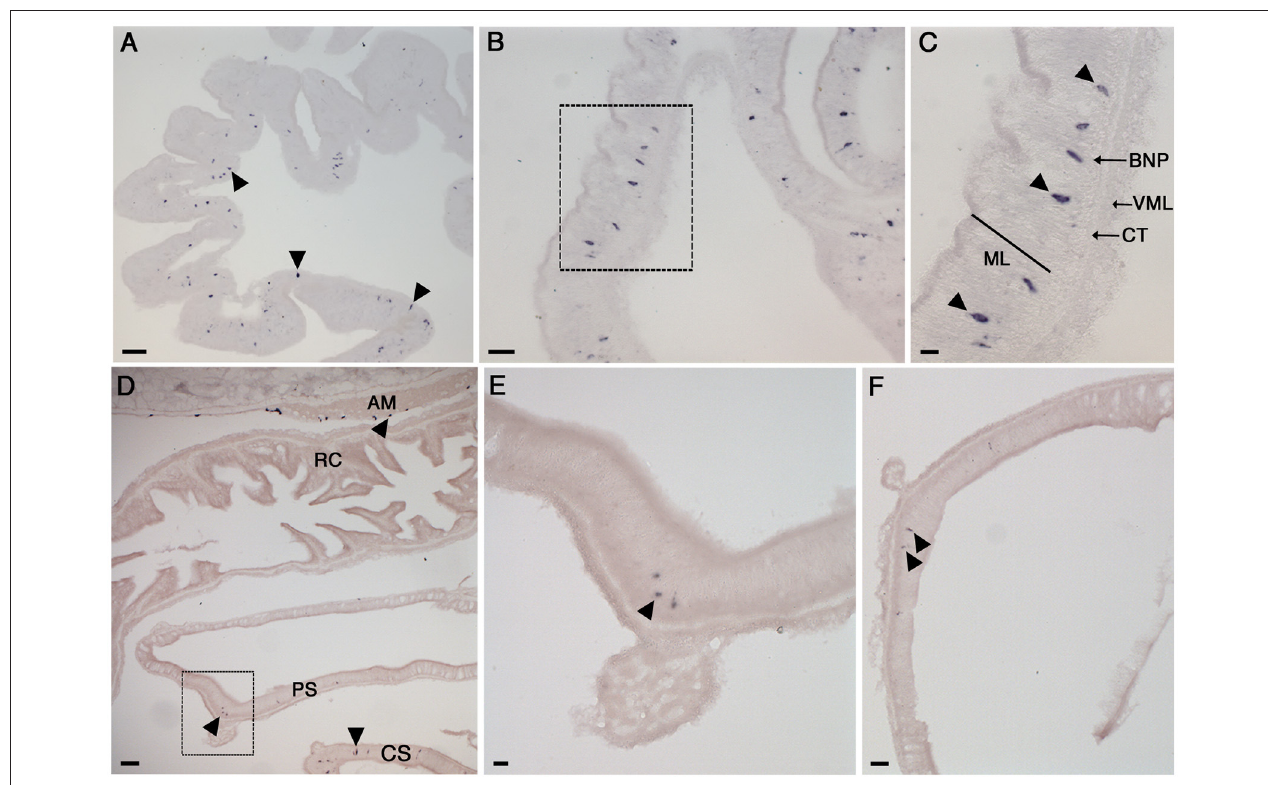
FIGURE 5 | Localization of NGFFYamide precursor mRNA expression in the digestive system of A. rubens . (A) Low magnification image showing stained cells (arrowheads) widely distributed in a section of a highly folded aboral region of the cardiac stomach. (B) Stained cells in the cardiac stomach, with the boxed region shown at a higher magnification in (C) , where stained cells (arrowheads) can be seen to be located in the mucosal layer or just beneath the basiepithelial nerve plexus. (D) Transverse section of the central disk region showing the cardiac stomach, pyloric stomach, rectal caeca and apical muscle. Stained cells can be seen in the cardiac stomach, pyloric stomach and apical muscle (arrowheads) but not in the rectal caeca. A higher magnification image of expression in the apical muscle is shown in Figure 6E and the boxed region of the pyloric stomach is shown at higher magnification in (E) . (F) Stained cells (arrowheads) in a transverse section of a pyloric duct. AM, apical muscle; BNP, basiepithelial nerve plexus; CT, collagenous tissue layer; CS, cardiac stomach; ML, mucosal layer; PS, pyloric stomach; RC, rectal caeca; VML, visceral muscle layer. Scale bars: (A) : 33 µ m; (B) : 16 µ m; (C) : 6 µ m; (D) : 33 µ m; (E) : 16 µ m; (F) : 16 µ